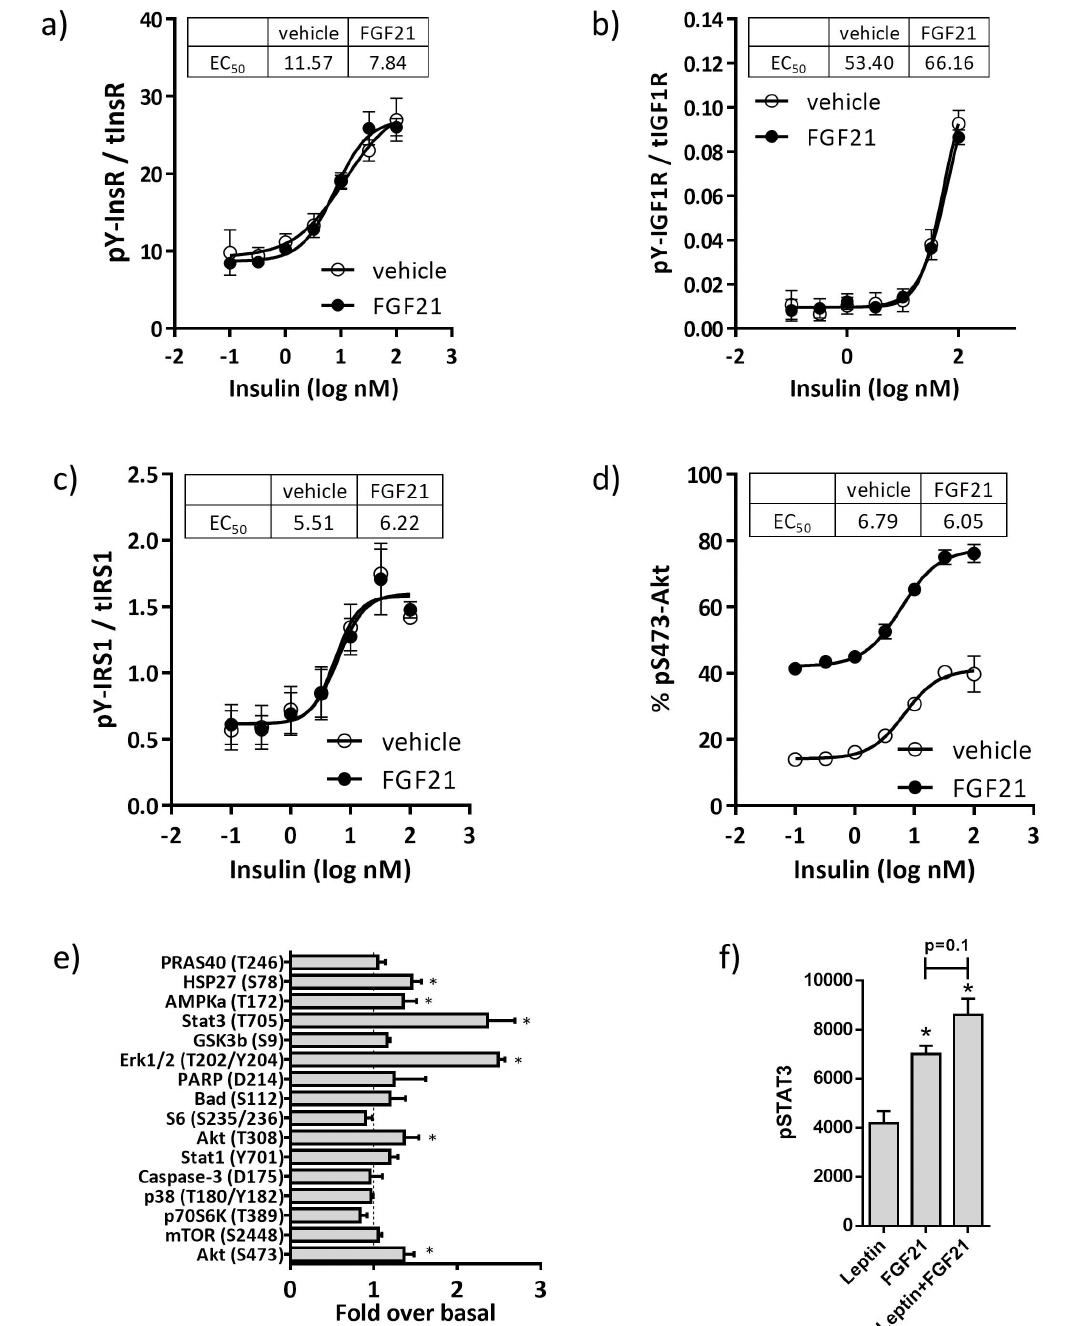
Figure 3. Activation of the insulin signaling pathway by FGF21 occurs downstream of IRS-1. hASC-adipocytes were treated with insulin, without (veh, open-circles) or with 100 nM FGF21 (closed-circles) for 5 min, then assayed for a) insulin receptor tyrosine phosphorylation, b) IGF1R tyrosine phosphorylation, c) IRS1 tyrosine phosphorylation, and d) Akt serine-473 phosphorylation. The level of each phosphoprotein was normalized to their respective total protein content. Each value represents mean 6 S.D. from 3 replicate wells. d) Effects of insulin with or without FGF21 cotreatment on signaling. Insulin EC 50 is displayed. e) PathScan analyses of intracellular proteins in absence and presence of 100 nM FGF21 treated- hASC-adipocytes for 10 min. *p , 0.05 vs basal. f) Phosphorylation of STAT3 upon treatment with leptin alone, FGF21 alone, or in